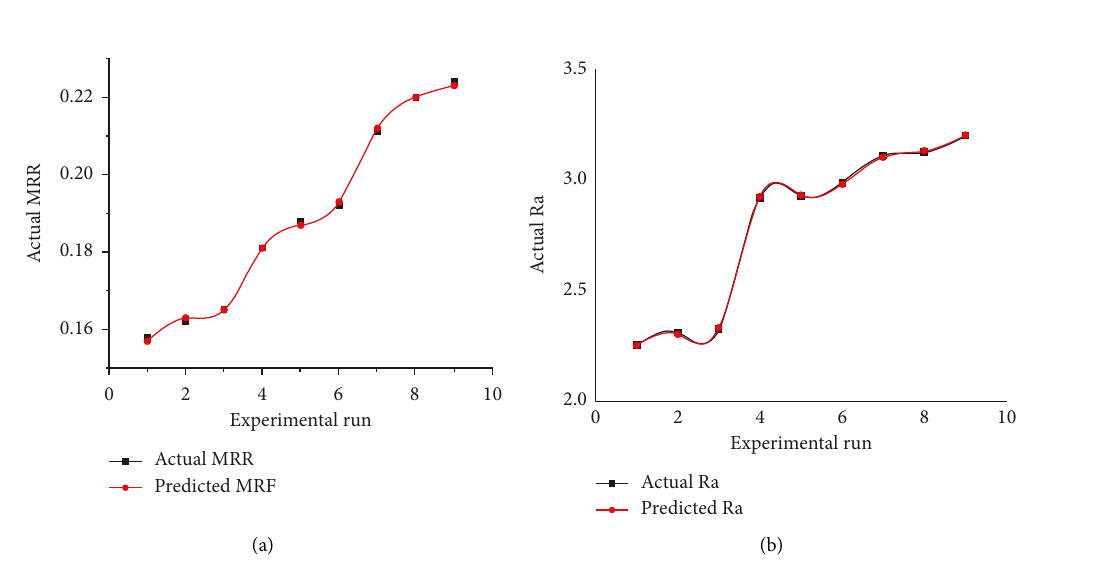
Figure 3: Comparison graph for experimental values with predicted values: (a) MRR, (b) R